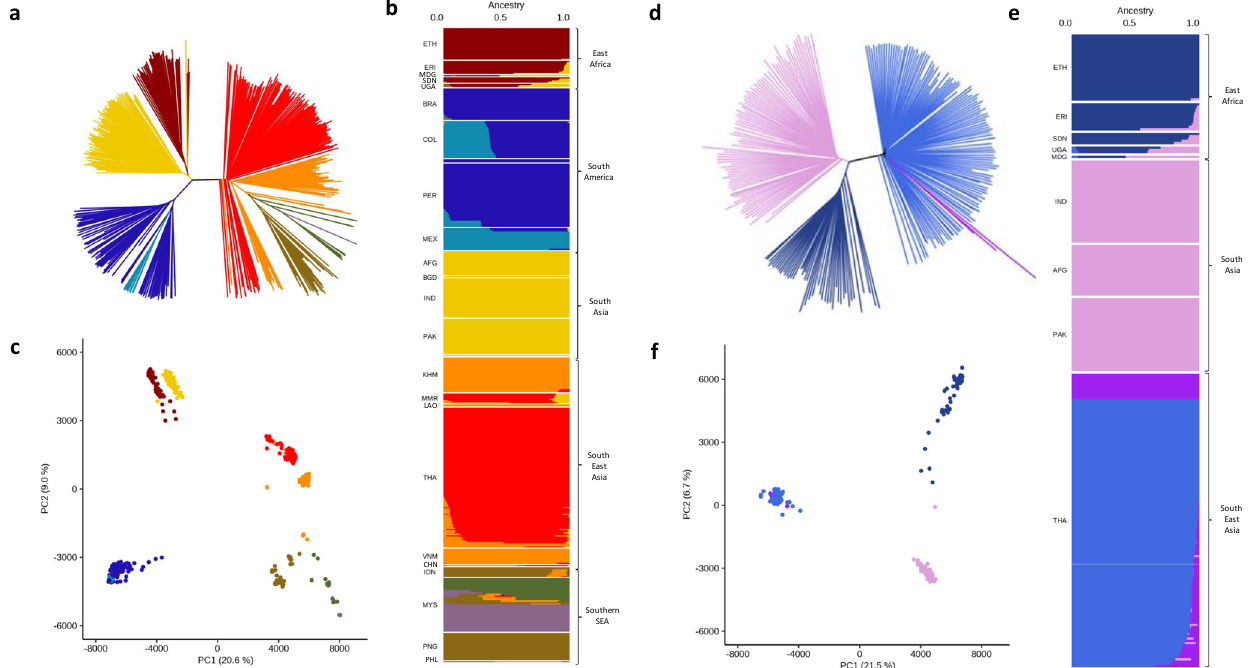
Fig. 1 Population structure analysis using the whole set of 558 P. vivax isolates. Analysis of the whole set supports one unique non-differentiated subpopulation for the South Asian isolates. a Neighbour-Joining tree for the 558 isolates, constructed using a genetic distance based on 388,933 high- quality SNPs, and branches coloured based on ( b ); b ADMIXTURE prediction of a subpopulation ( K = 9) visualised using a bar plot. c Principal Components Analysis (PCA) plot of the 558 isolates, with colours based on ( b ). d Neighbour-Joining tree for South Asia (India 36, Pakistan 32, Afghanistan 22), and East Africa (Ethiopia 29, Eritrea 12, Sudan 5, Uganda 3, Madagascar 1). Thailand isolates (128) were used as a representative population from South East Asia. Tree branches are coloured based on the assignment of the subpopulation from ( e ). e An ADMIXTURE bar plot illustrating the population structure ( K = 4), highlighting a distinction between South Asian countries and Thailand, and East Africa and Thailand. The plot also highlights a degree of mixing between East African and South Asian populations. f PCA plot using the same data as in ( d